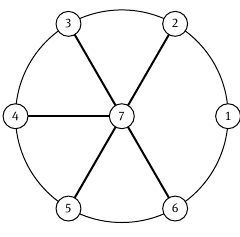
Figure 3.2: The graph W (6, 5) with a (2, 5) -regular set S = { 1, 2, 3, 4, 5, 6 } .